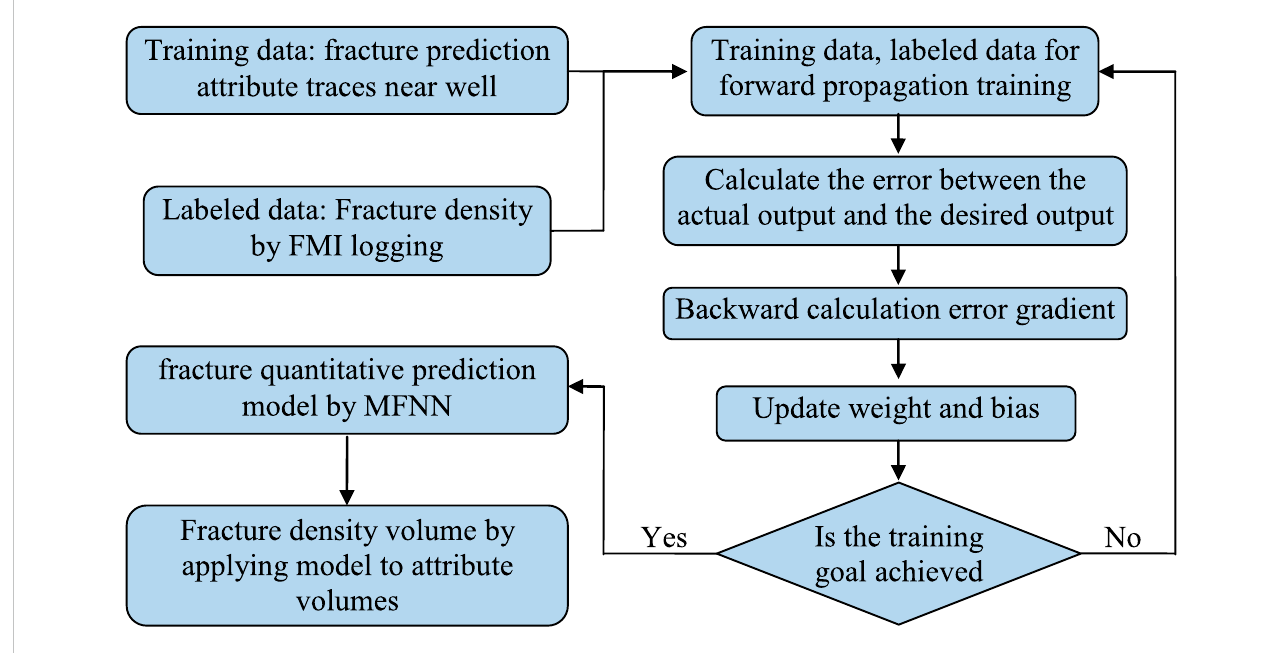
FIGURE 4 Flow chart of fracture quantitative prediction model using multilayer feedforward neural